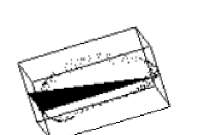
Fig. 9. Sole and its bounding box.